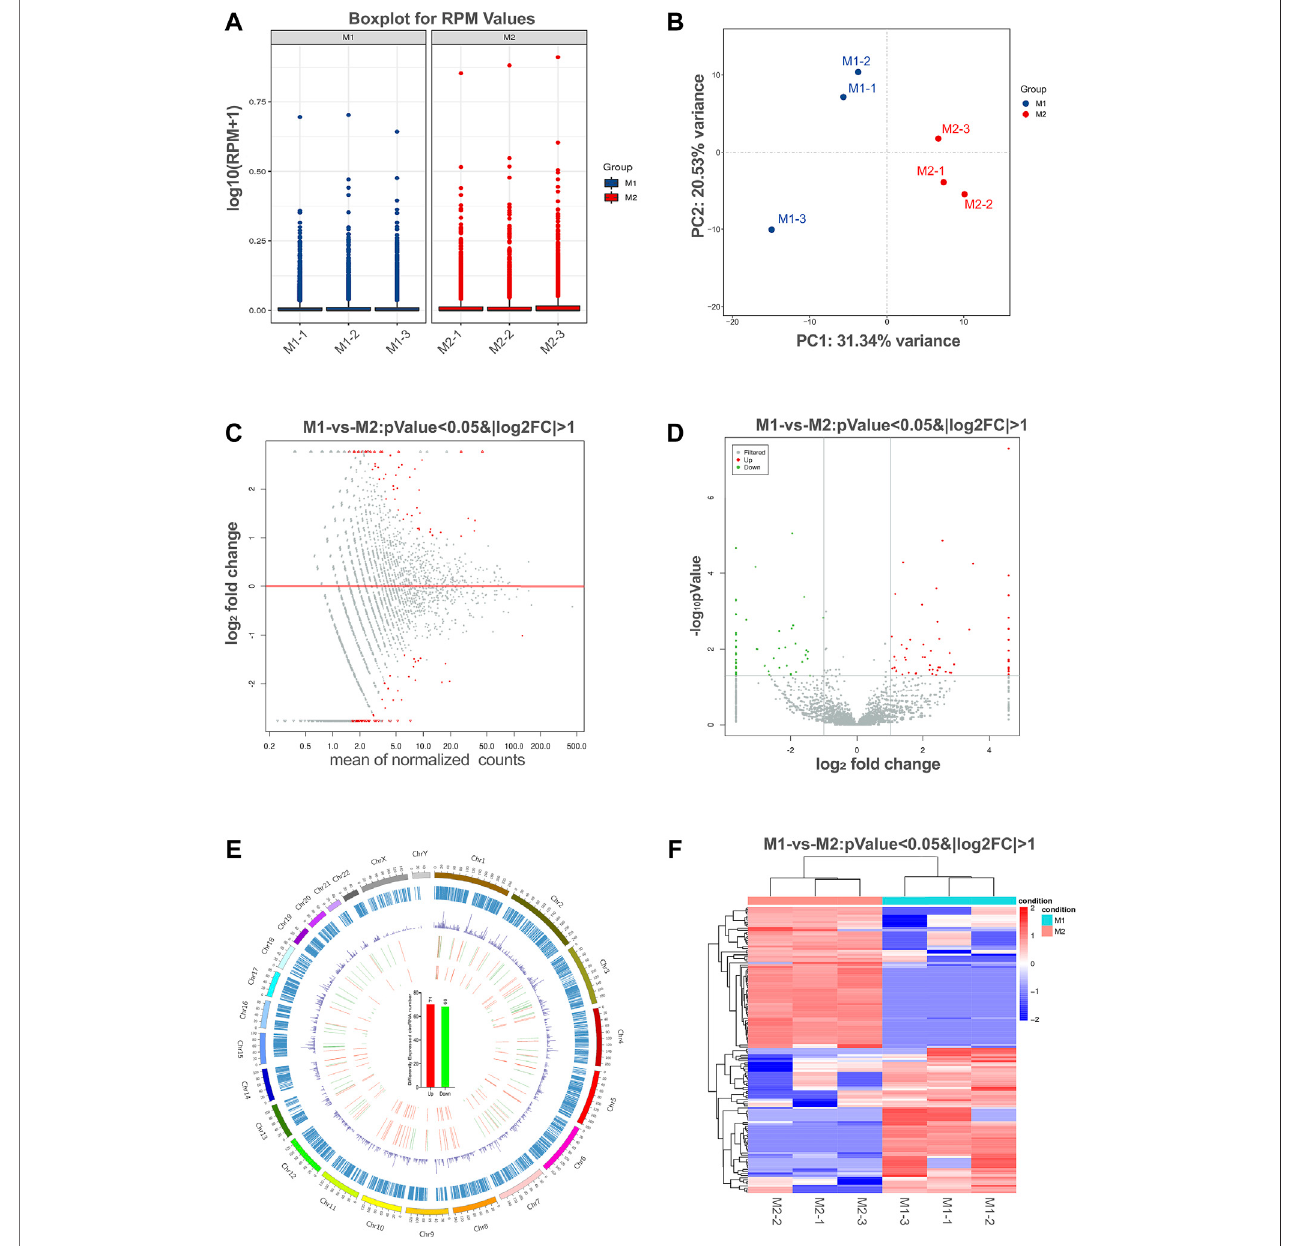
FIGURE 3 | Differential expression of circRNAs in polarized macrophages. (A) Box plots of reads per million (RPM) values of circRNAs for the six samples after normalization. (B) Scatter plots of all samples for principal component analysis on the fi rst principal component (PC1) and the second principal component (PC2). (C) MA scatter plots of sequencing data assessing overall distribution of the two sets of data. Labeled red portions indicate differentially expressed circRNAs ( p < 0.05 and |log2FC| > 1). (D) Volcano plot showing number and distribution of circRNAs in the same plane. (E) Chromosome distribution of up- and down-regulated circRNAs. (F) Heat map showing differentially expressed circRNAs from M1 macrophages compared with M2 macrophages. Each row represents one circRNA, and each column represents each sample. Red indicates up-regulation; blue indicates down-regulation.